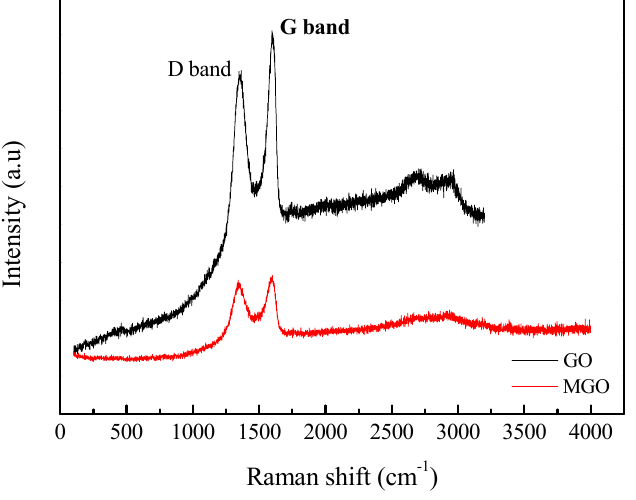
Figure 3. Raman spectra of GO and MGO.